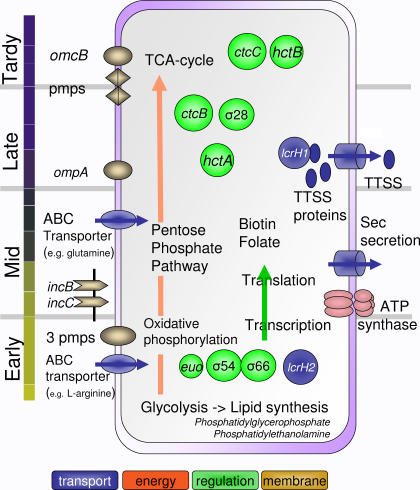
Schematic Overview of Important Cellular Functions Correlated with the Expression Profiles and Cluster ClassesThe illustration presents an overview of a C. pneumoniae cell, and the onset of gene expression for genes with important cellular functions according to their cluster classes. Gene identification numbers, gene definitions, and gene names can be viewed at http://www.ncbi.nlm.nih.gov.